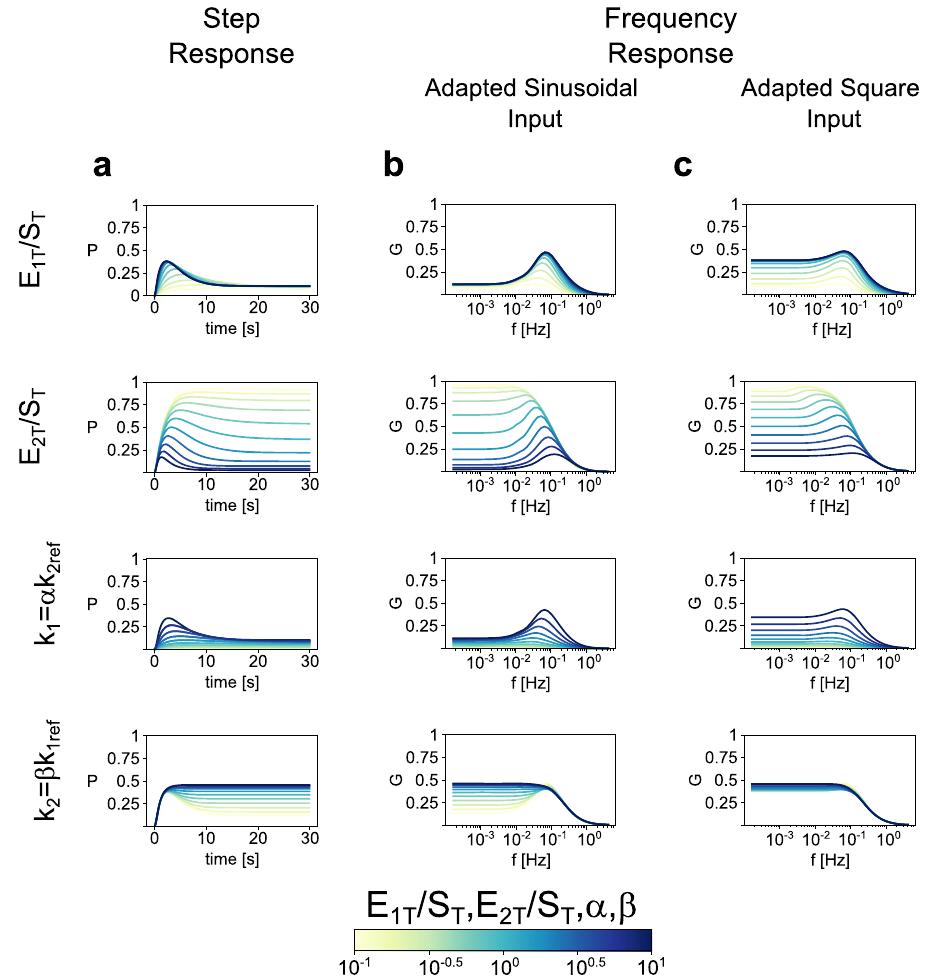
Fig. 7 Analysis of the mechanisms leading to frequency preference. a P versus time for step (constant) stimulation. b Gain versus frequency under sinusoidal stimulation. c Gain versus frequency under the train of square pulses stimulation. Each row corresponds to different parameter variations controlling the transition in or out of the signal termination region. First row, E 1T / S T ; second row, E 2T / S T ; third row, k 1 = = β k α k 2re f ; fourth row, k 2 1ref , with k 2ref and k 1ref the corresponding parameter values for a reference set (as in Fig. 5). These parameter variations are color-coded as indicated in the color bar at the bottom of the fi